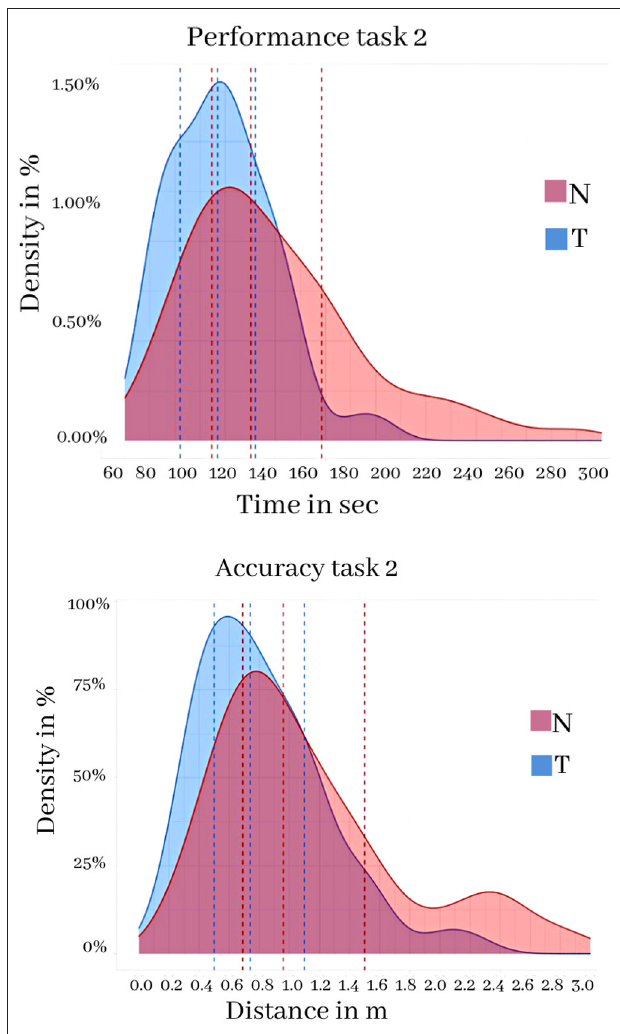
FIGURE 11 | Accuracy task 2 in the two conditions N and T. Top: performance measured as task execution time. Bottom: accuracy as average distance from the beacons. Vertical lines indicate the first, second and third quartiles (25, 50, 75%).